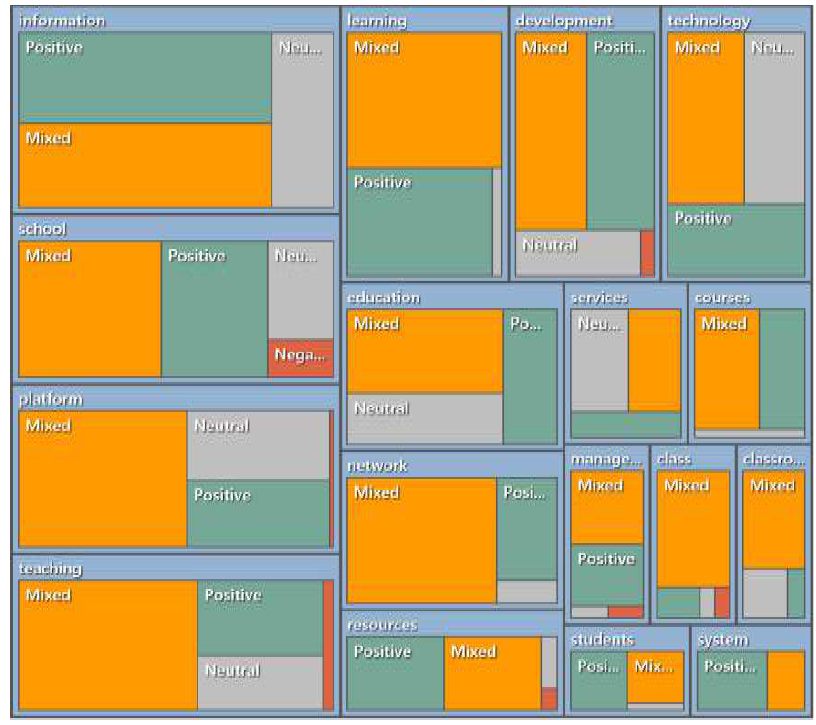
Figure 5. Coding hierarchy of teachers’ attitudes towards digitalization in HESD Table 2. Coding and reference of attitudes towards digitalization of HEI